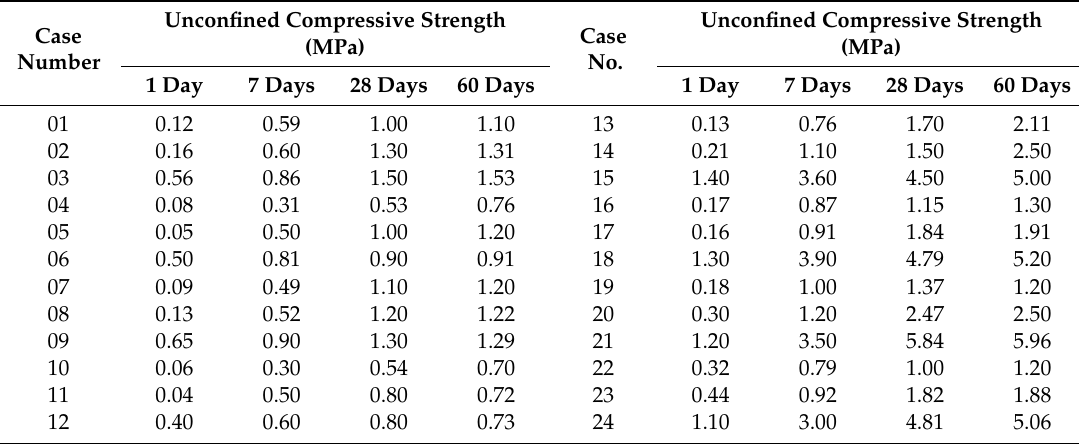
Table 6. Unconfined compressive strength test